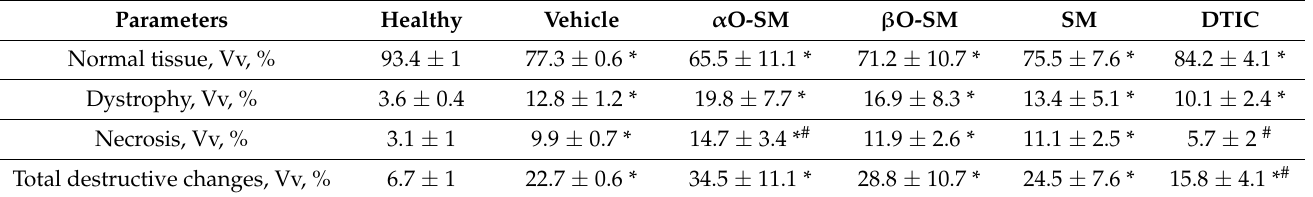
Table 4. Morphological changes in the kidney tissue of healthy mice and mice with B16 melanoma without treatment and after administration of studied